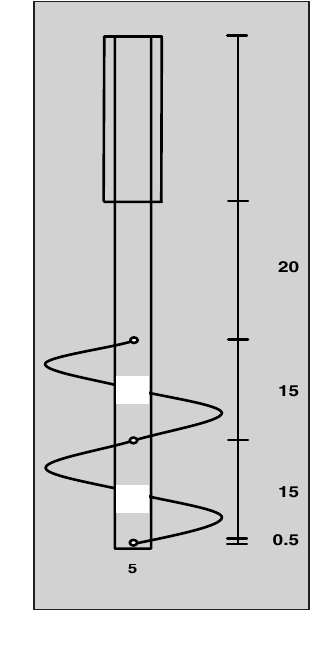
Figure 1: Helical ribbon stirrer used to mix suspension and